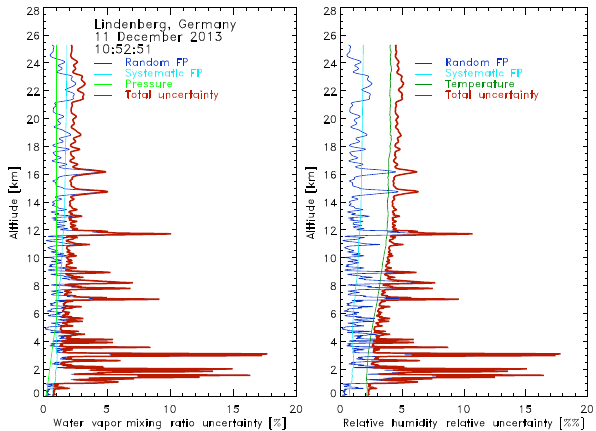
Figure 10. Profiles of the uncertainty budget for water vapor mixing ratio (left) and relative humidity (right).